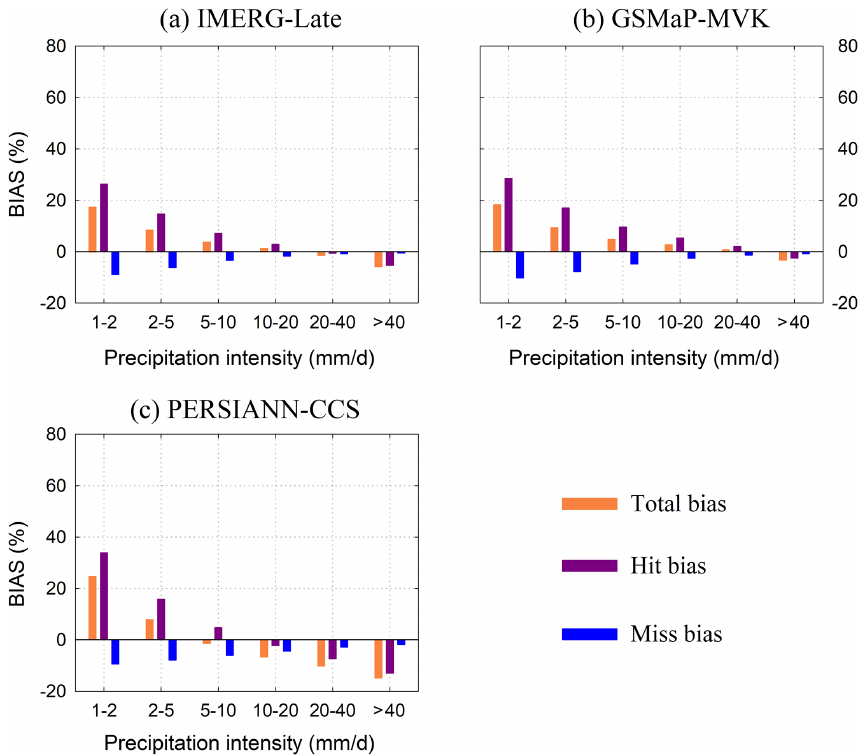
Figure 7. The three bias scores (i.e., total bias, hit bias, and miss bias) for the three satellite-only global precipitation estimates (i.e., IMER- GLate, GSMaP-MVK, and PERSIANN-CCS) at a spatial resolution of 0.5 ◦ and daily temporal resolution under different rainfall intensities. Note that the precipitation intensity categories are from references: (a) IMERG-Late, (b) GSMaP-MVK, (c)